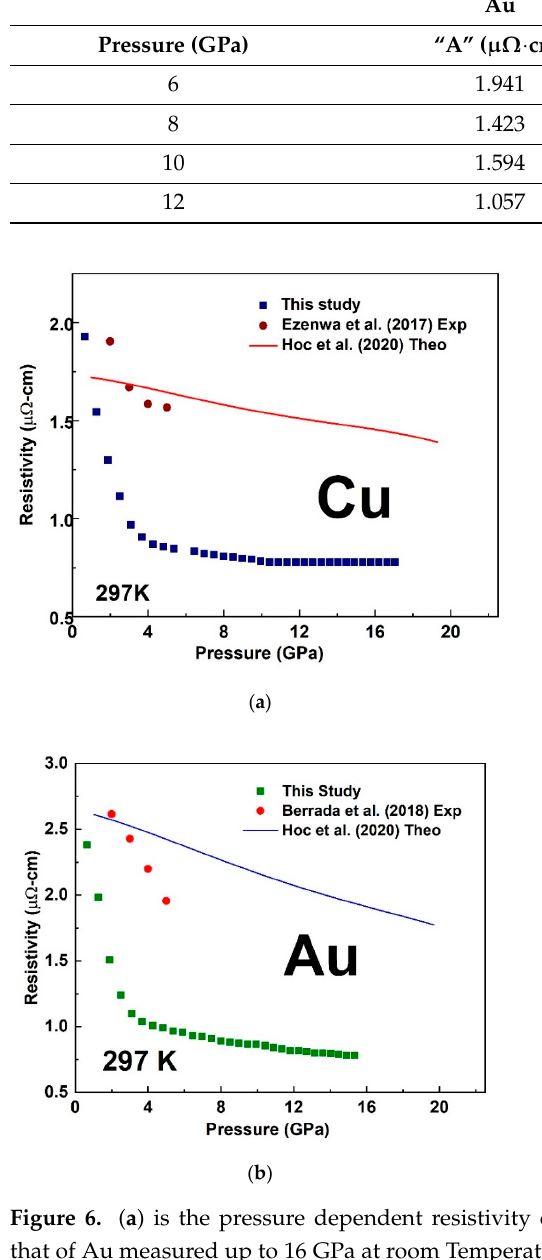
Table 2. Tabulated fitting parameters at various fixed pressures for Au runs.